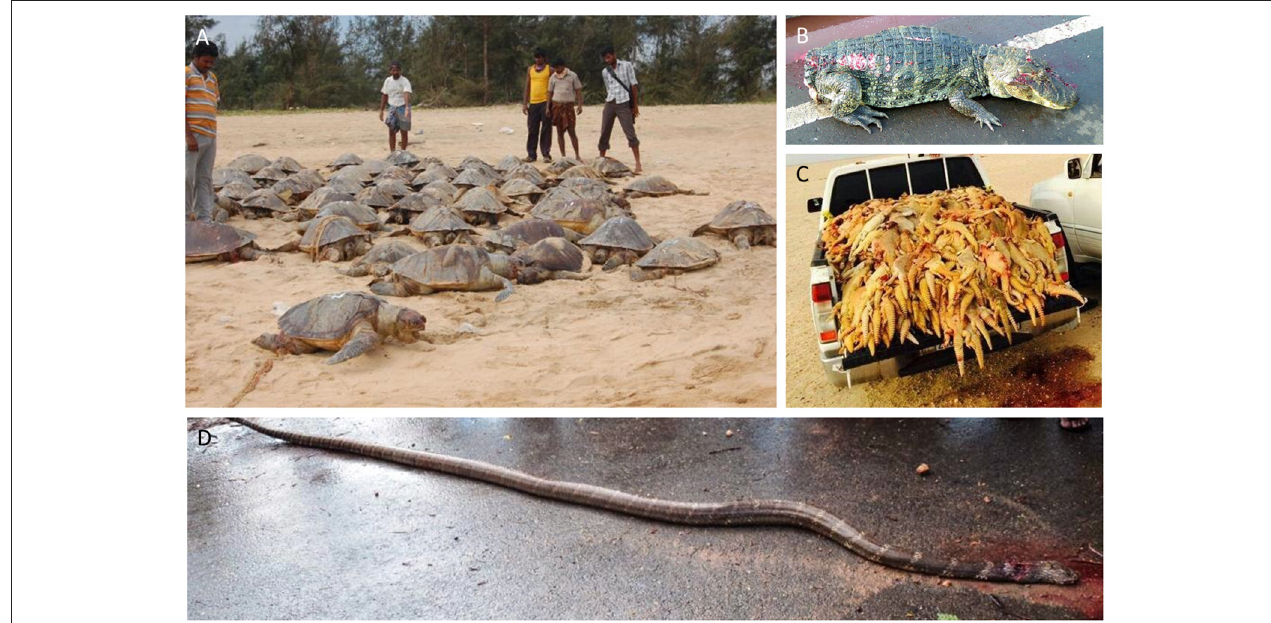
FIGURE 2 | Examples of reptiles’ roles imperiled by human activities: (A) By-catch events drown up to 9,000 olive ridley turtles per year in Odisha, India (Behera et al., 2016)—sea turtles provide important surfaces for encrusting epibionts (Bjorndal and Jackson, 2003; Photo: Supraja Dharini). Crocodilians are important nutrient linkers (Nell and Frederick, 2015), and (B) shows a broad-snouted caiman ( Caiman latirostris ) with tail amputed while it was alive (Photo: Andrei Jara). Ecosystem engineers such as spiny tailed lizards ( Uromastyx aegyptia ) create burrows that offer refuge to other species in their native desert landscapes (Williams et al., 1999); they are, however, are hunted in their hundreds for meat, as seen in (C) (Anonymous photo). Reptiles can be important predators, yet, they are widely feared (Shankar et al., 2013); (D) shows the snake-eating king cobra ( Ophiophagus hanna ), killed by local villagers in India (Photo: Eastern Ghats Wildlife Society).